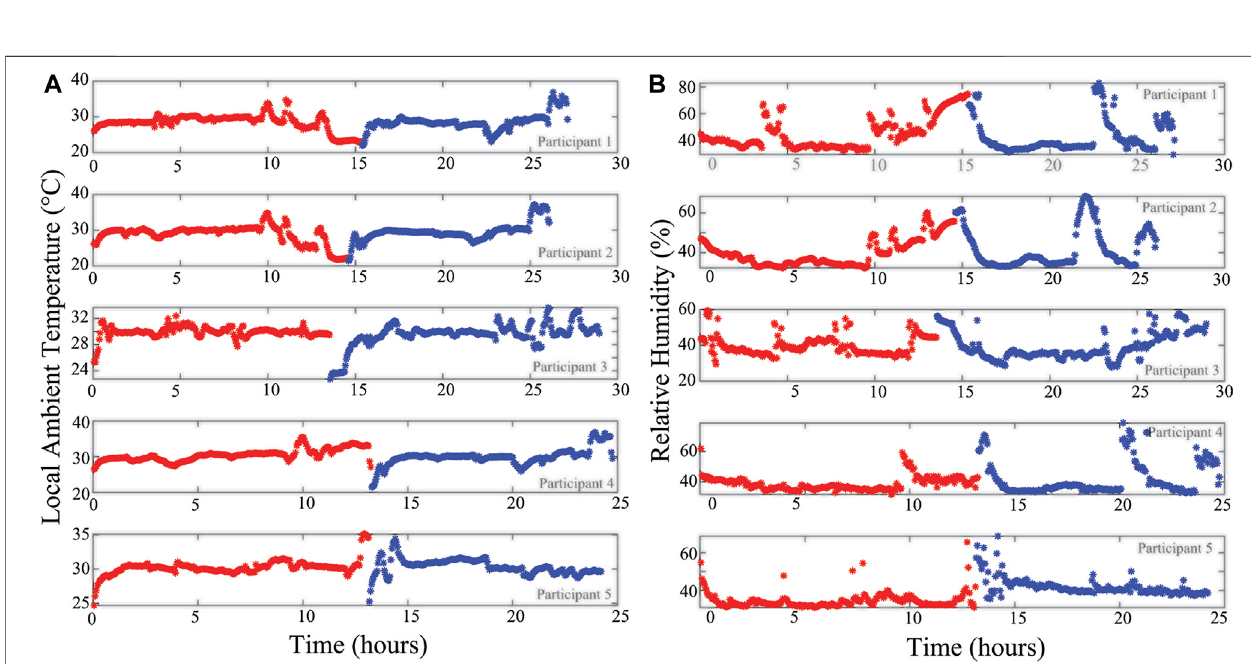
FIGURE 9| (A) Acceleration magnitude and (B) MAD representing activity at participants knee collected using wearable system across days 1(red) and 2 (blue) of data collection.